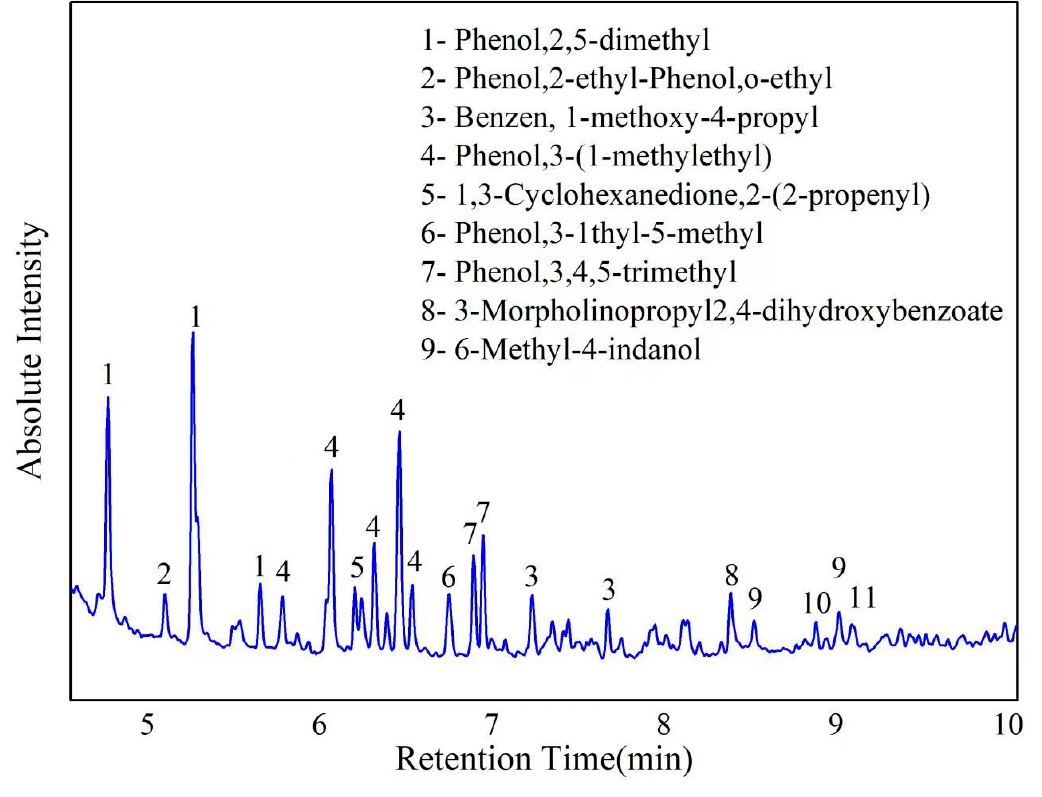
Figure 1. GC analysis of spent caustic.